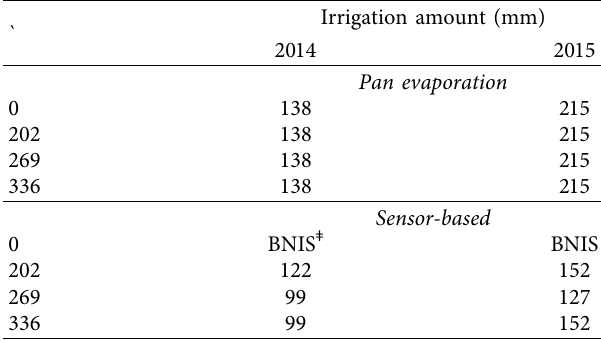
Table 4: Seasonal irrigation on corn under different irrigation scheduling methods and N rates in 2014 and 2015 at